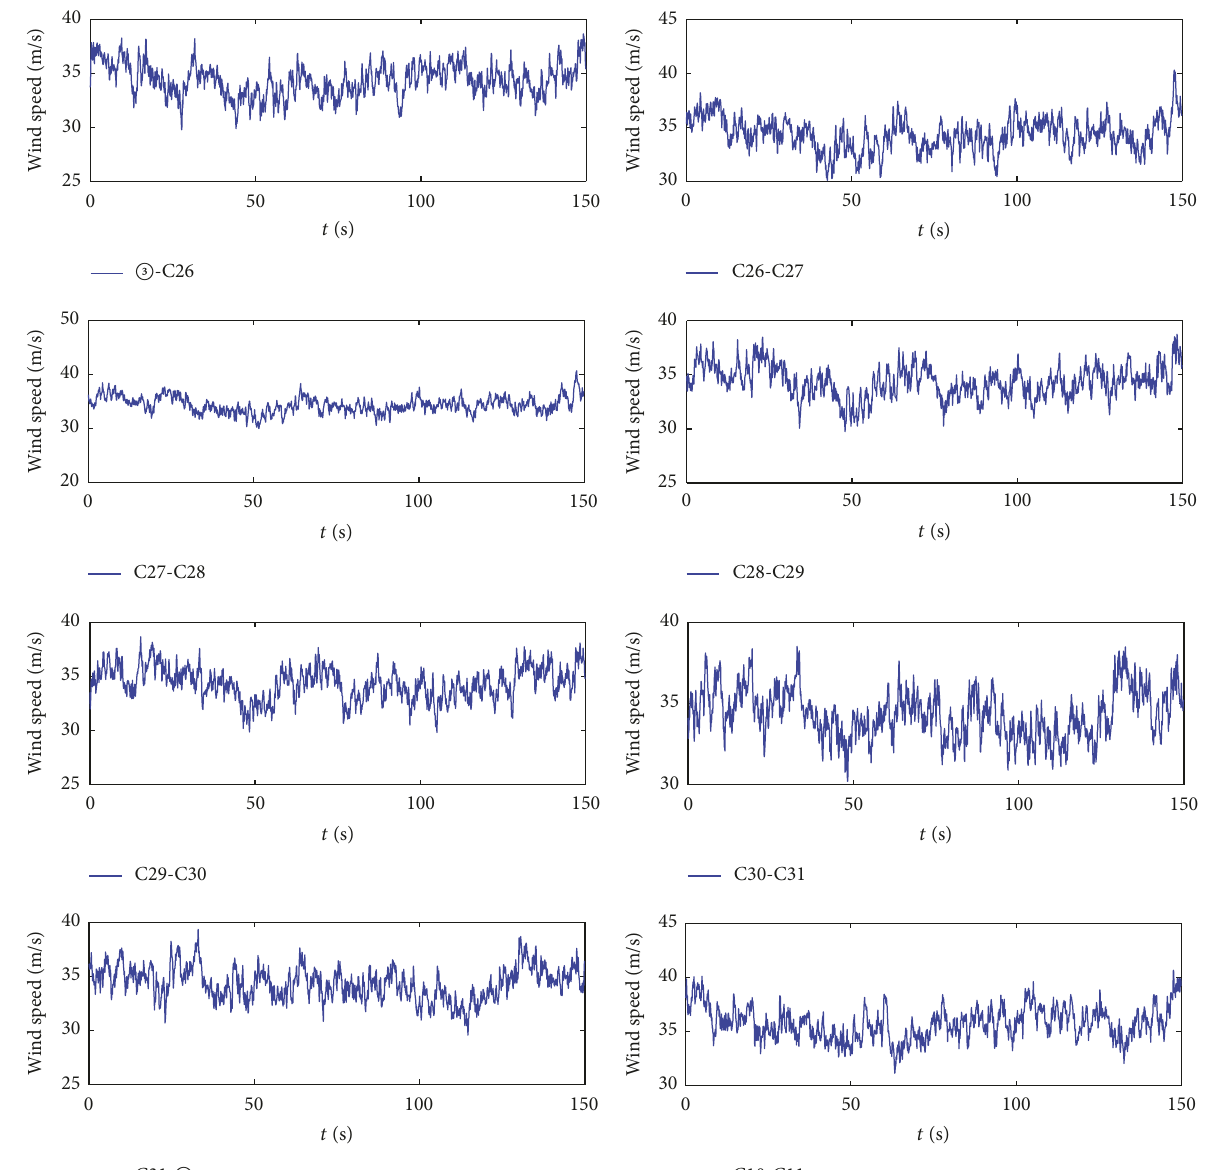
Figure 12: The simulated wind speed time history of the transmission lines between transmission towers number 159 and number 160.